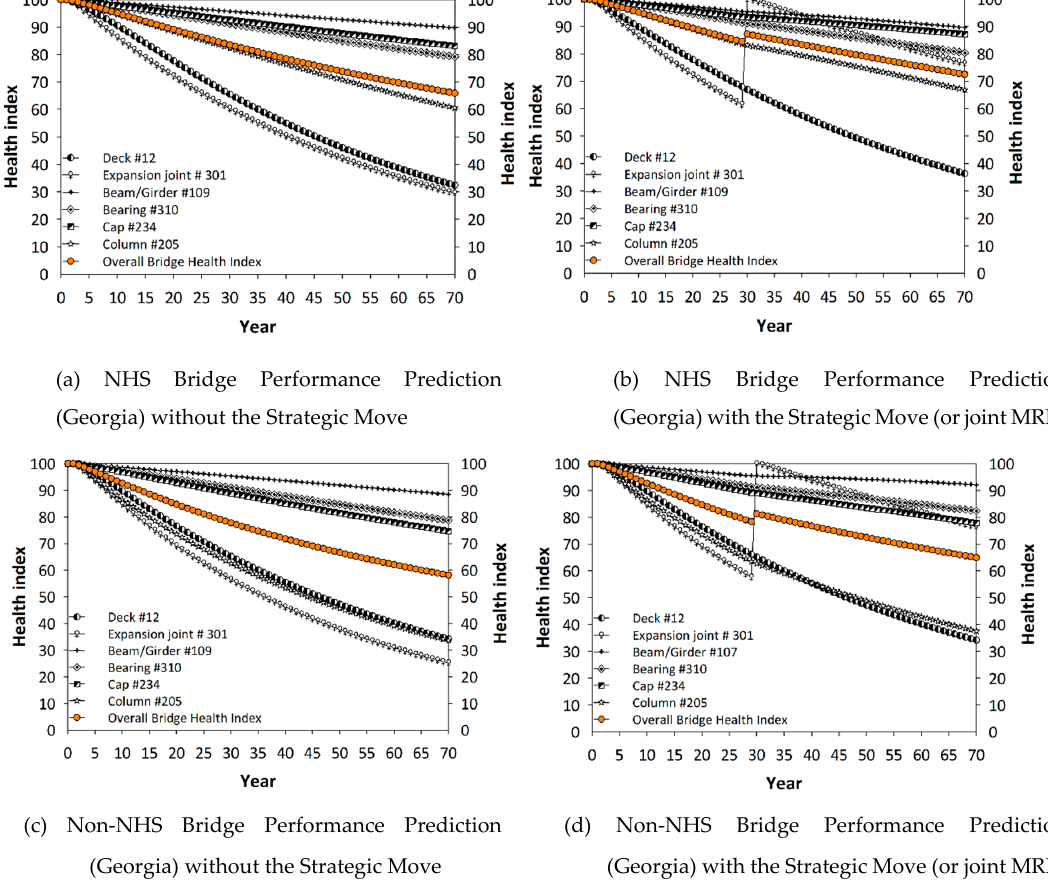
Figure 2. National Highway System (NHS) vs. non-NHS bridge in Georgia.